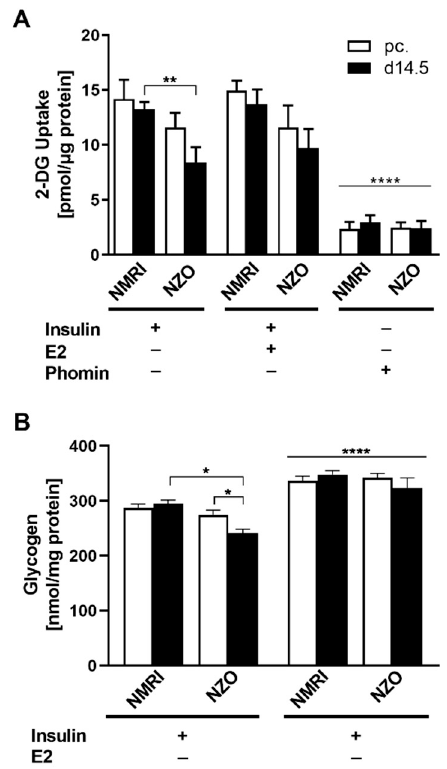
Figure 4. Impact of E2 on glucose uptake and glycogen in primary hepatocytes. ( A ) 2-DG uptake with insulin and E2 co-stimulation or Phomin control and ( B ) glycogen content with insulin preincubation and E2 stimulation in cultured primary hepatocytes of NMRI and NZO mice at time points preconceptional (white bars) and d14.5 (black bars). Data are presented as means ± SEM (( A ) n = 5–6, ( B ) n = 5 animals per group). * p < 0.05, ** p < 0.01, multiple comparison tests results between groups: + I vs. + Phomin: **** p < 0.0001, + I vs. + I + E2: **** p < 0.0001.